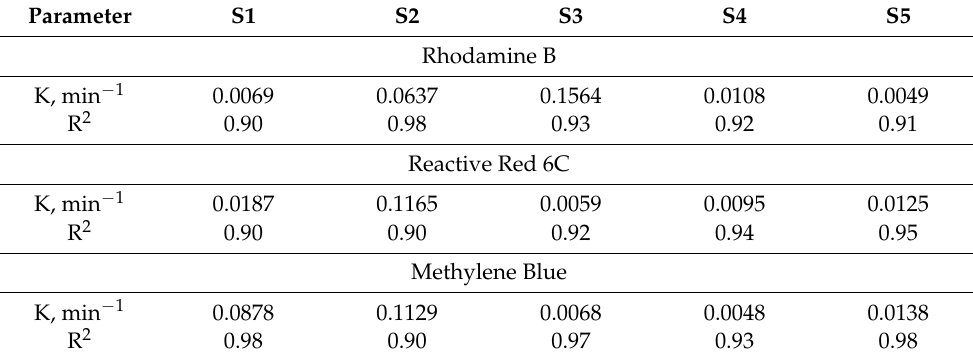
Table 7. Kinetic parameters of photocatalytic destruction of dyes.